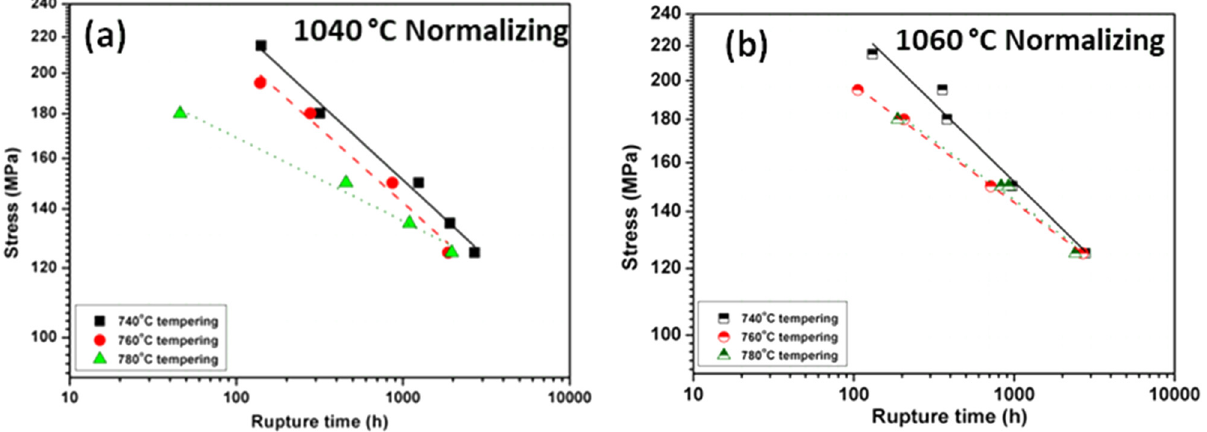
Figure 9: Summary of the stress rupture data revealing the effect of tempering temperature for creep tests at 650°C, for normalizing temperatures of ( a ) 1040°C ( b )